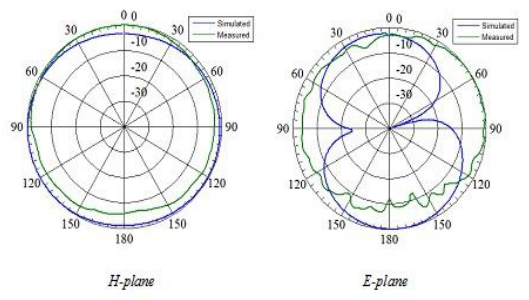
Fig. 12 : Radiation pattern of Antenna-1 at 5 GHz. Table II: Antenna parameters